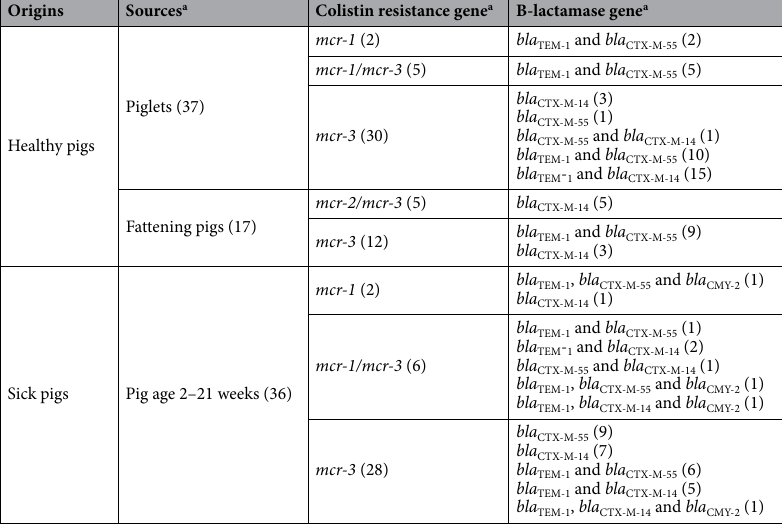
Table 5. The presence of mcr and β-lactamase genes in E. coli from healthy and sick pigs (n = 454) in Thailand between 2007 and 2018. a Numbers in parenthesis indicate the number of positive E. coli isolate(s).